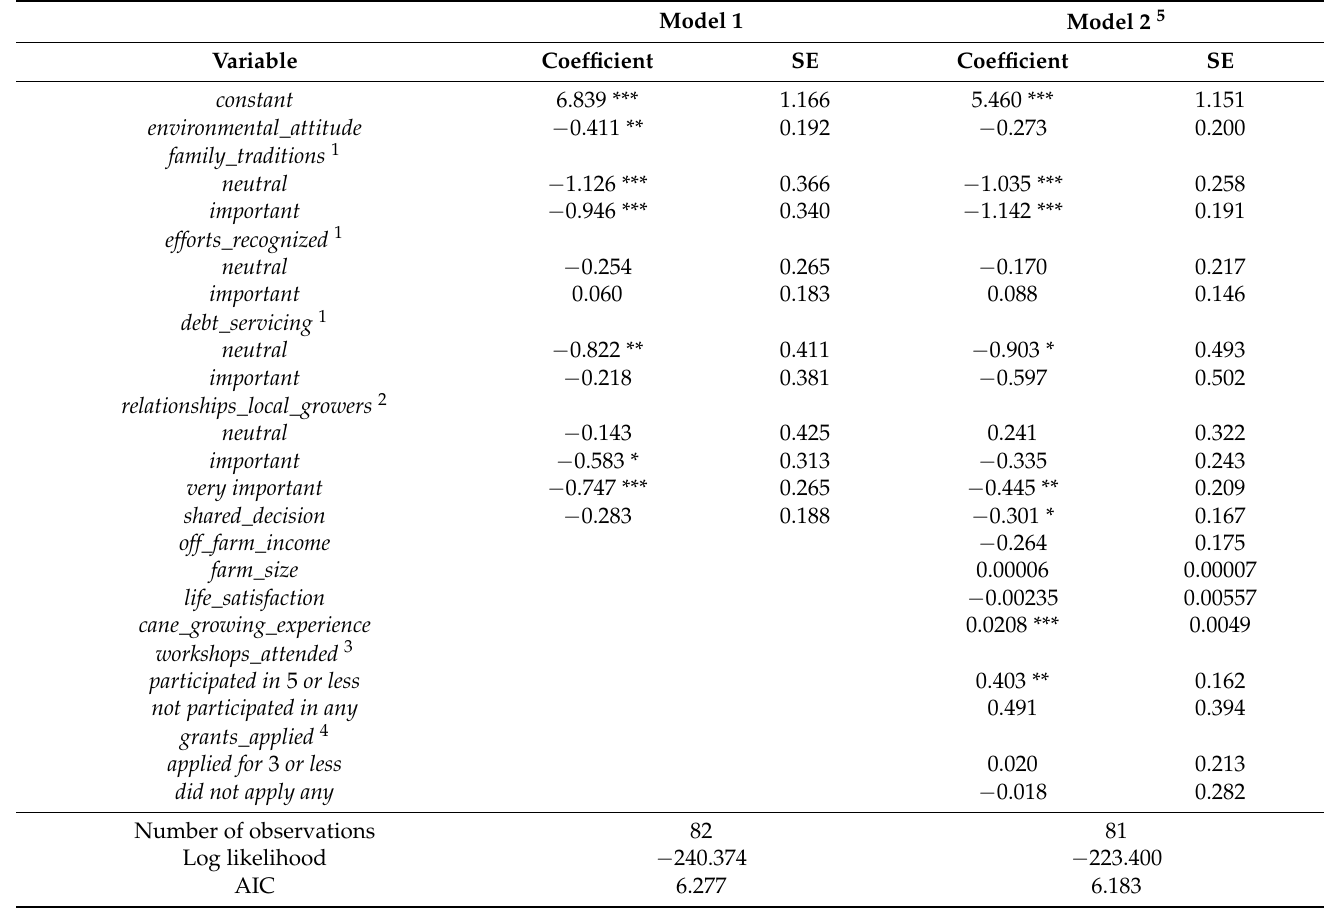
Table 3. Negative binomial regression results for Model 1 (TPB construct included as independent variables) and Model 2 (all independent variables are included). Dependent variable: